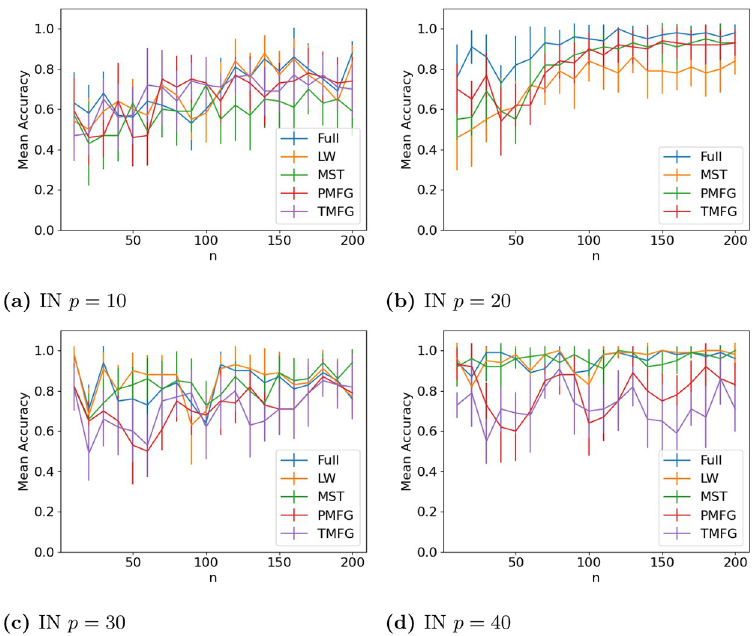
Fig 18. Accuracy when distinguishing between correlation matrices inferred from adjacent time windows based on the median volatility using the SF method and a random forest classifier for Indian stock returns. (a) IN p = 10, (b) IN p = 20, (c) IN p = 30, (d) IN p = 40.